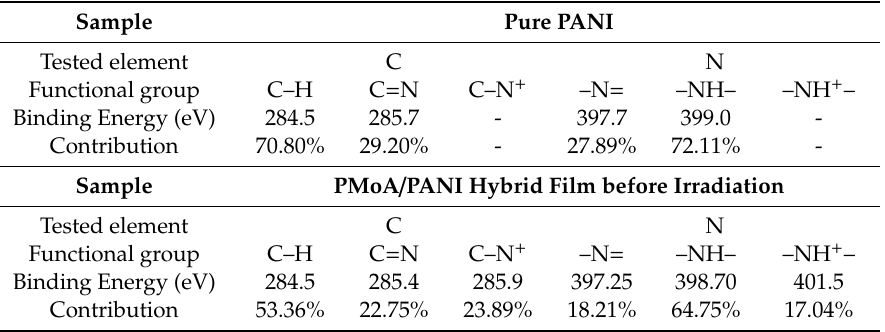
Figure 4. ( a ) XPS photoelectron spectrograms of PANI and PMoA/PANI hybrid thin films before illumination. ( b ) XPS photoelectron spectrogram and Gaussian deconvolution curve fitting for C 1s. ( c ) XPS photoelectron spectrogram and Gaussian deconvolution curve fitting for N 1s. Table 1. Comparison of C– and N-related functional groups of pure PANI and the. PMoA / PANI hybrid film before irradiation.